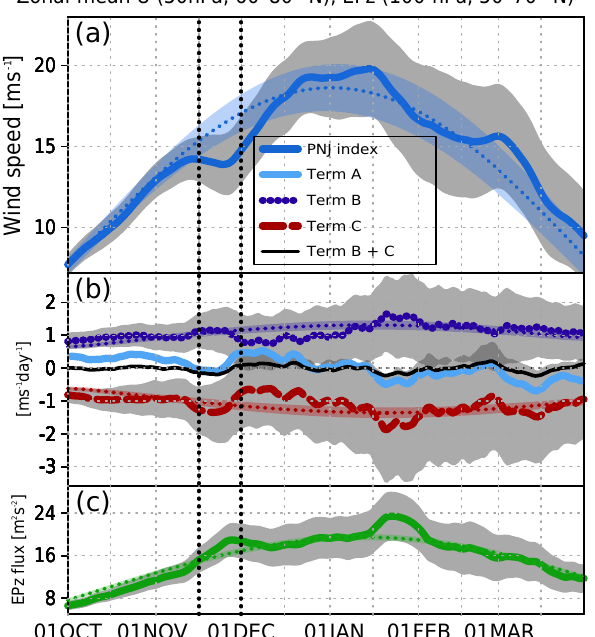
Figure 2. Time series of climatological 15-day running means of the (a) PNJ index (ms − 1 , dark blue) (same as Fig. 1b); the sinusoidal regression expression of the PNJ index, dark blue dotted line); the 95% confidence interval of the indices (color shading); (b) the tem- poral tendency of the PNJ (i.e., zonal acceleration (ms − 1 day − 1 ); Term A in Eq. 3, light blue line), the Coriolis force acting on the residual mean meridional circulation and the meridional advection of zonal momentum (ms − 1 day − 1 , Term B in Eq. 3, purple line) at 50hPa, and the EP flux divergence (ms − 1 day − 1 , Term C in Eq. 3, red line) at 50hPa averaged over latitudes 60–80 ◦ N; the sum of Term B and Term C (black line); the sinusoidal Term B (purple dot- ted line), and the sinusoidal Term C (red dotted line); the 95% con- fidence interval of the indices (color shading); and (c) the vertical component of EP flux ( F z ) , the sinusoidal of the F z (green dotted line), and the 95% confidence interval of the indices (color shading) at 100hPa (10 − 2 m 2 s − 2 ) averaged over latitudes 50–70 ◦ N from 1 October through 31 March. The vertical black dotted lines indicate the period of the late November short break.